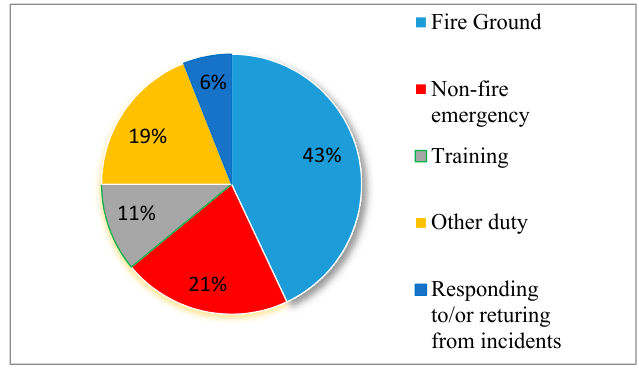
Figure 1. US firefighter injuries by type of duty during 2015 1.